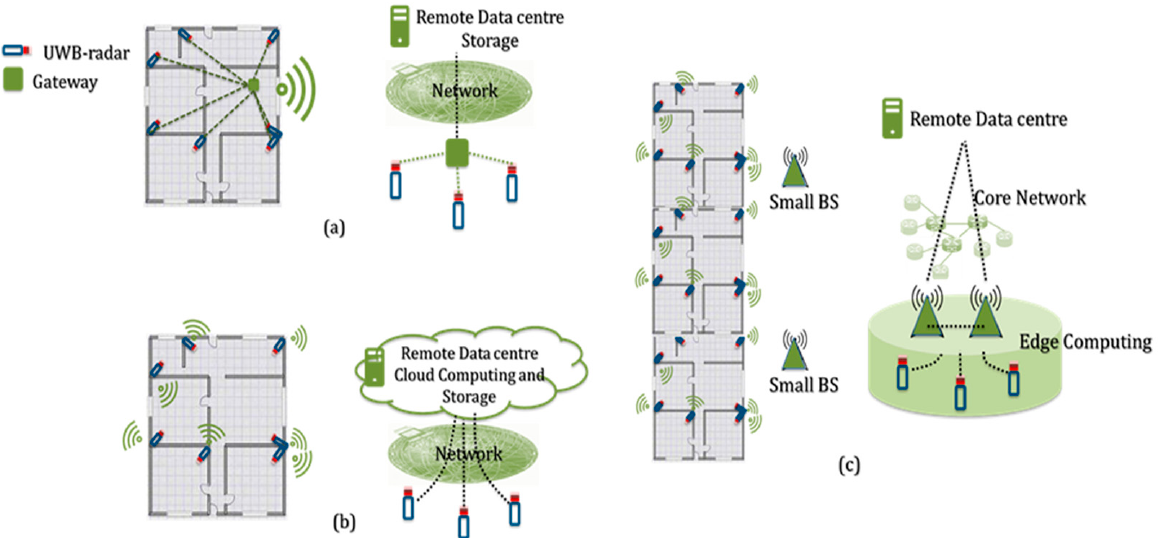
Figure 6. Overall network architecture: ( a ) hierarchical architecture; ( b ) UWB-radars directly connected; ( c ) architecture based on cellular features, such as 5G/6G.